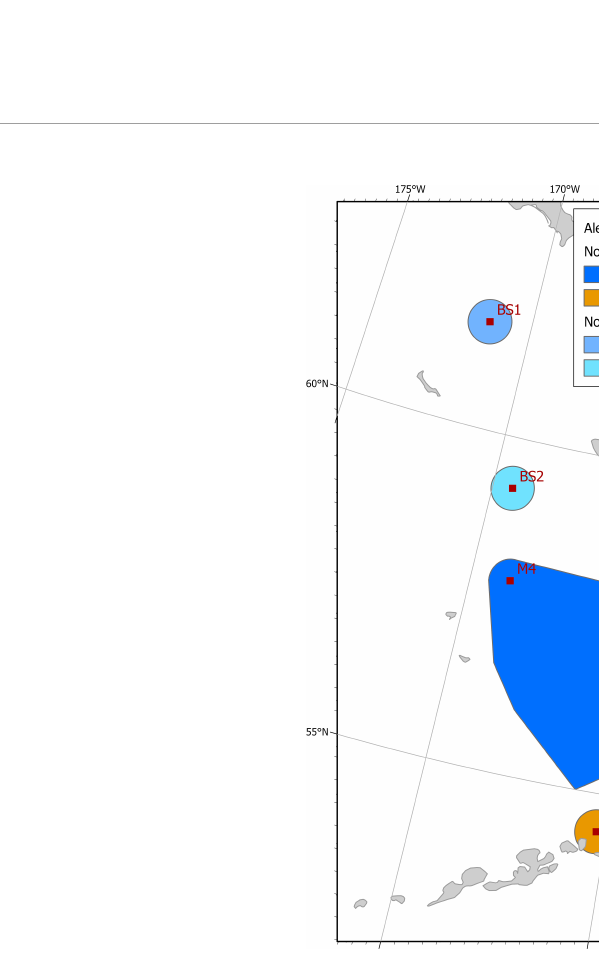
FIGURE 7 Aleutian Islands and Bering Sea region North Paci fi c right whale BIAs and watch list areas.